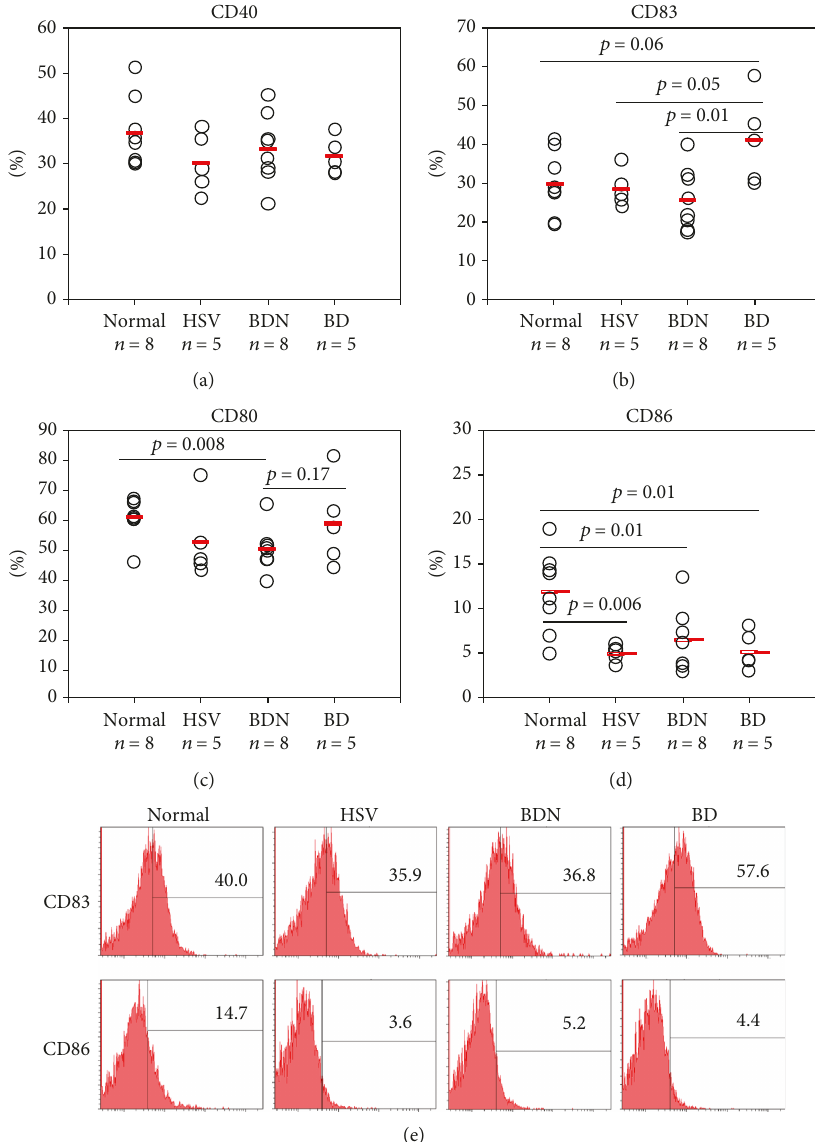
Figure 1: (a – d) Frequencies of DC costimulatory molecules CD40, CD83, CD80, and CD86 in the surface of peripheral blood leukocytes (PBL) were evaluated by fl ow cytometry analysis. (e) Representative histogram of frequencies of CD83+ and CD86+ cells in PBL. The p value was determined by Student ’ s t -test. The number of mice used for experiments are 8 in normal, 5 in HSV-1, 8 in BDN, and 5 in BD. n indicates the number of mice in each group. Experiments were performed more than three independent